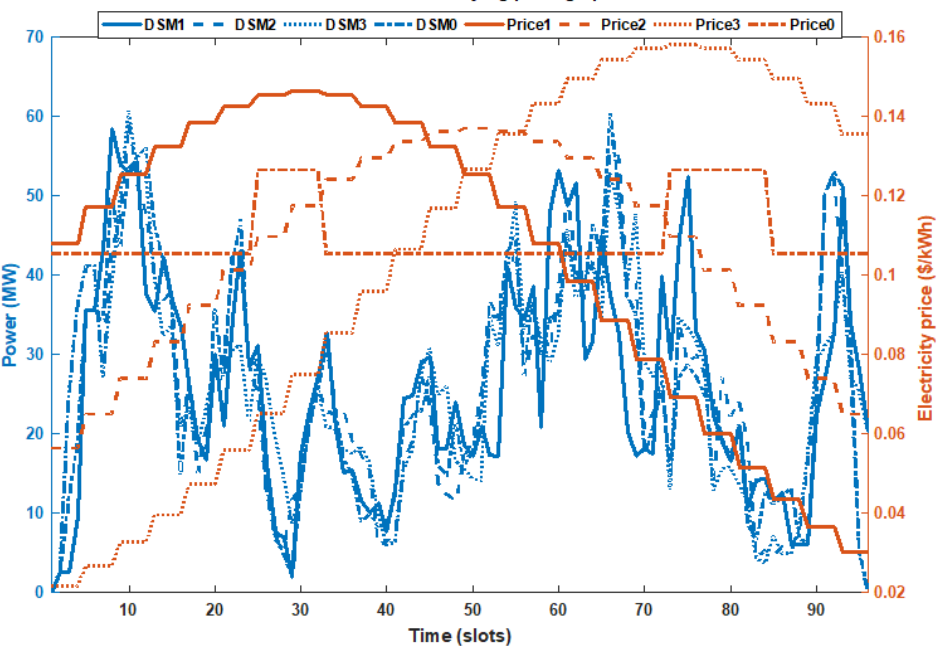
Figure 12. Price1 (DSM1), Price2 (DSM2), Price3 (DSM3) and Price0 (DSM0) DR dispatch